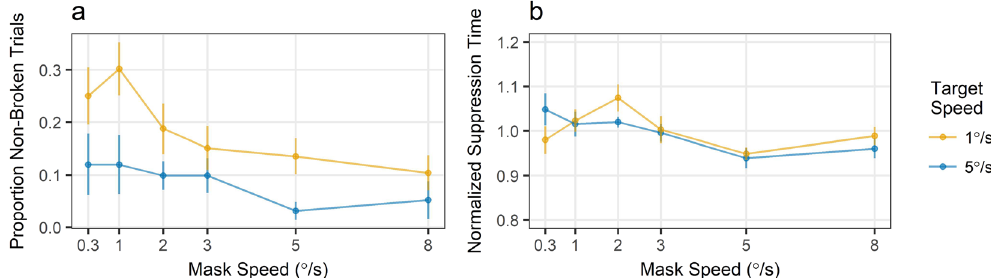
Figure 4. The relationship between the target and mask speeds, and suppression effectiveness in Experiment 3. The distance targets traveled on each iteration was tied to their velocity. ( a ) Faster targets were more consistently detected. ( b ) The effect of the target speed on detection times was no longer significant. Dots are group means with error bars reflecting standard